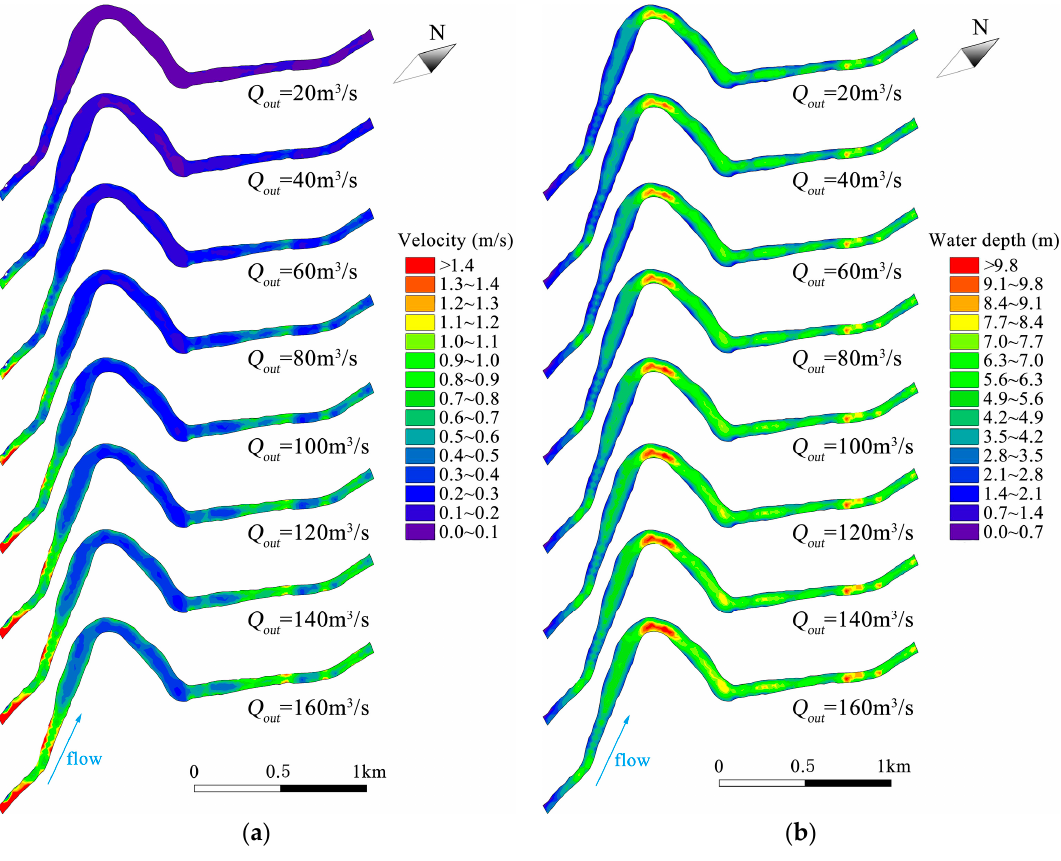
Figure 9. The spatial distribution of velocity and water depth under different reservoir outflows: ( a ) velocity and ( b ) water depth.